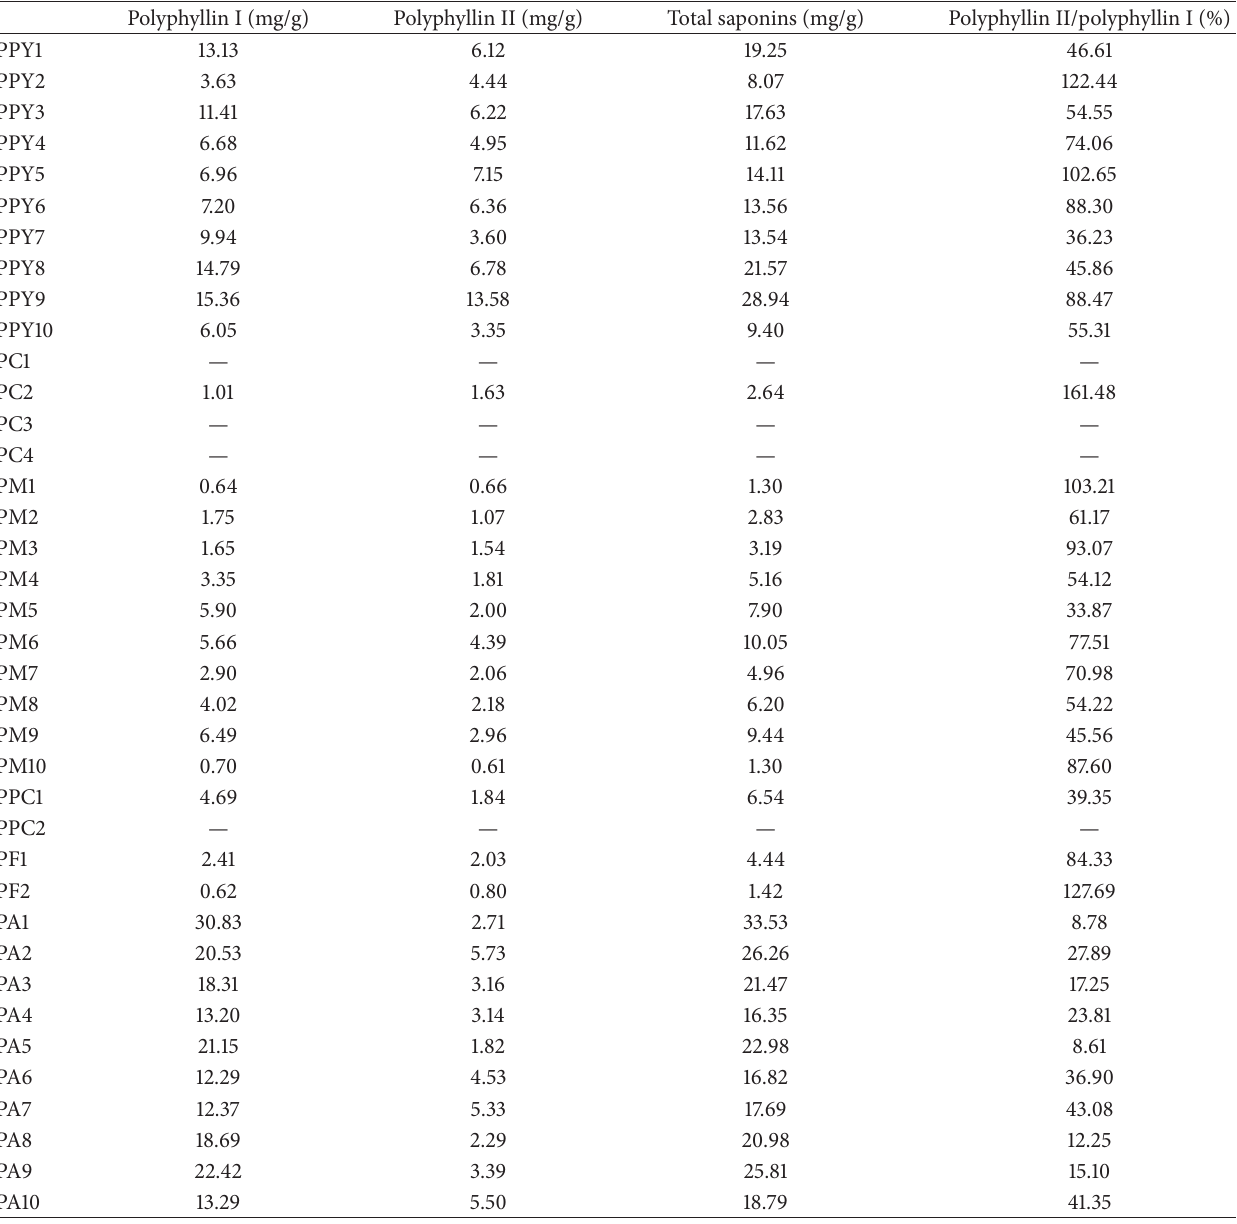
Table 4: Content of polyphyllin I and polyphyllin II of six species of 38